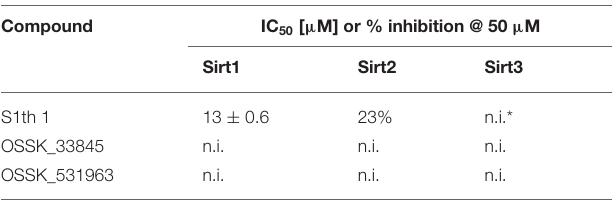
TABLE 1 | Inhibition of class I sirtuins by S1th 1 and its two structural analogs OSSK_338451 and OSSK_531963 (2nd round of in vitro screening).